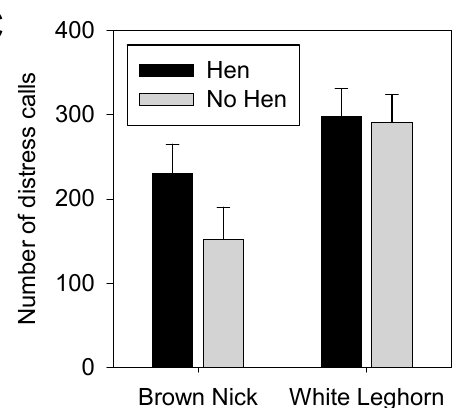
Figure 2. Results of open field testing for the parameters ( A ) latency to walk, ( B ) number of lines crossed, and ( C ) number of distress calls. Significant main effects of chicken line were found on latency to walk and number of distress calls. No significant effects of hen raising or line × hen raising interactions were observed. Bars represent averages and Standard Errror of the Mean (SEM).